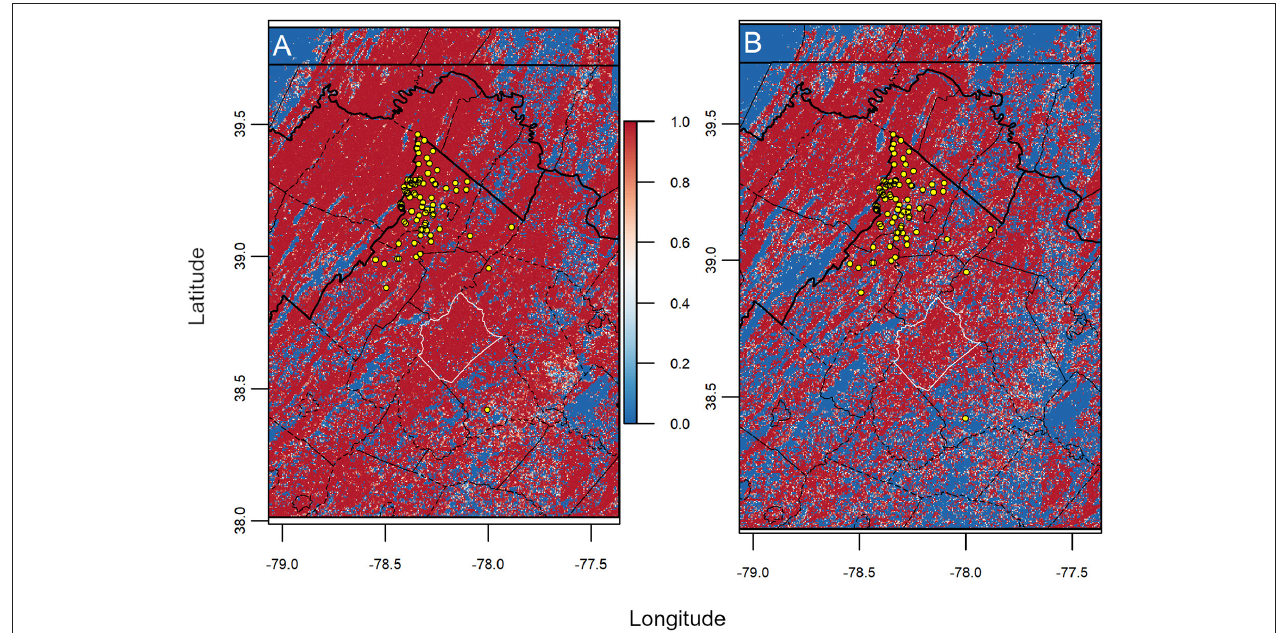
FIGURE 6 | Maps of projected CWD transmission risk from uncertainty analysis. Risk maps identify areas determined with more consistent probable risk (red) and less consistent risk (blue) for CWD transmission from jackknife analysis. We found more homogenous and widespread transmission risk being consistent among models using (A) Harvest Locations compared with (B) Home Ranges . Note that counties with considerable transmission risk include Rappahannock County (white outlined polygon). Lines indicate boundaries of states (thick black) and counties (thin black), while points (yellow circles) represent known CWD cases ( n = 88). Overall, the amount of area predicted as consistently risky was higher in models generated from Harvest Locations